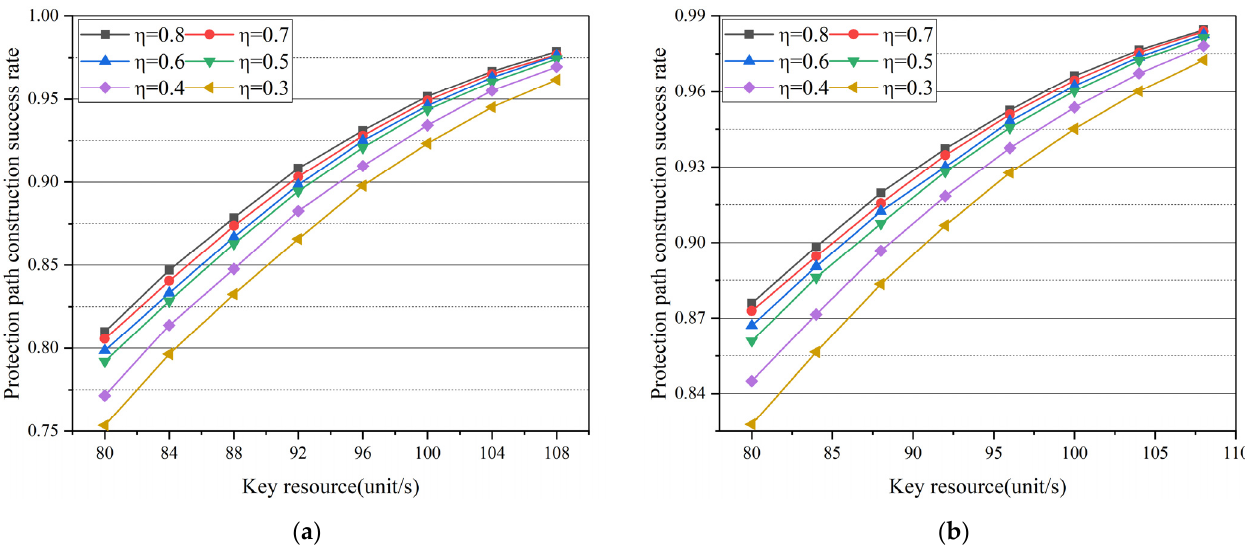
Figure 8. Simulation results: ( a ) protection path construction success rate varies with link key resources in the case of different protection thresholds in NSFNET; ( b ) protection path construction success rate varies with link key resources in the case of different protection thresholds in USNET.